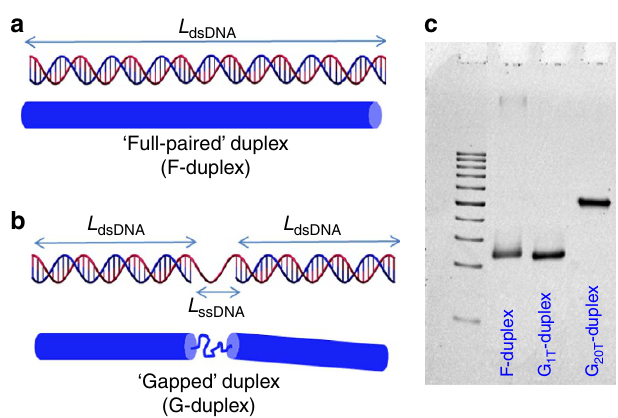
Figure 1 | Synthesis and characterization of full-paired and gapped DNA duplexes. Schematic representation of the DNA duplexes used for the exploration of the LC behaviour of rod-shaped molecules with tunable intrinsic flexibility. ( a ) dsDNA fragment formed by combining two complementary ssDNA strands (red and blue strands) with a length of L dsDNA ¼ 116bp B 38.3nm that is smaller than the dsDNA persistence 50nm. This molecule is referred to as the F-duplex, and is a length l ssDNA p ¼ model for a stiff rod as depicted in blue. ( b ) Three partially complementary ssDNA strands that form a DNA G-duplex. The red ssDNA strand has a length equal to the one used for the construction of the F-duplex in a . Base-pairing with the two shorter blue ssDNA strands results in a gapped layer spacing, as can be seen from the three top scattering patterns in G-duplex. The G-duplex thus consists of a central unpaired flexible ssDNA Fig. 2b: the spacing increases from 33.4 to 35.7nm on increasing the region with either 1 or 20 unpaired thymine bases, with a stiff dsDNA part concentration from 231.8 to 291.2mgml (cid:2) 1 . with L dsDNA ¼ 48bp attached to both sides of the flexible ssDNA part. The spacer with 20 unpaired thymine bases has a length L ssDNA that is much 2nm of the corresponding larger than the persistence length l ssDNA p ¼ ssDNA. ( c ) In all, 10% PAGE. From left to right: 50bp DNA Ladder (bottom to the top: from 50 to 500bp with a 50bp step), F-duplex (with L dsDNA ¼ 116bp), the G 1T -duplex, and the G 20T